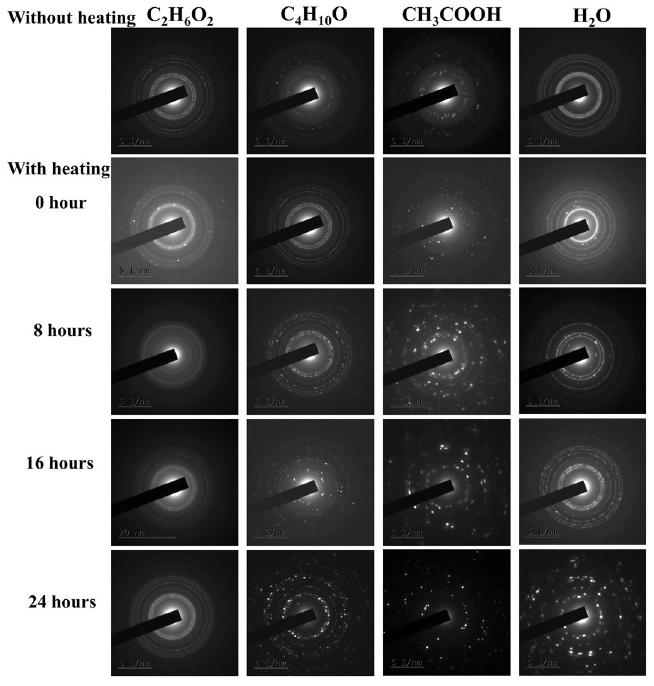
Figure 2. SAED pattern of synthesized ZnO nanostructures in distinct